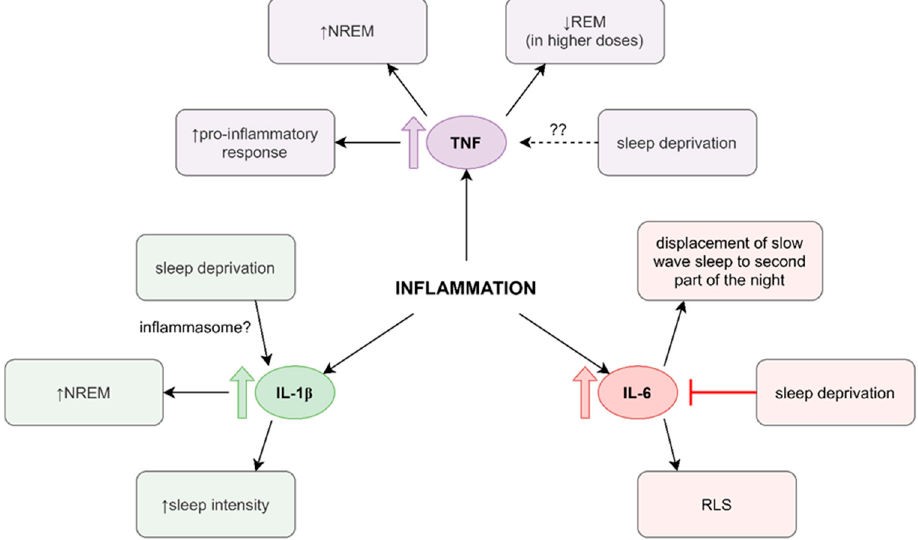
Figure 1. Sleep and inflammation. Notes: Inflammation is associated with relatively high levels of interleukin (IL) 6, IL-1 β , and tumor necrosis factor (TNF). IL-6 might promote slow-wave sleep in the second half of the night while suppressing it in the first half. It might also contribute to restless leg syndrome (RLS) through stimulation of hepcidin production, which can cause iron deficiency. Sleep deprivation (SD) early in the night might cause relatively low IL-6 levels and change its pattern of secretion. IL-1 β might improve non-rapid eye movement sleep (NREM) length and sleep intensity. Its levels increase after SD, suggesting the influence of SD on inflammasome, a potentially interesting subject for future studies. TNF stimulates immune response through suppression of Treg lymphocytes, recruitment of the immune cells, etc. It appears to promote NREM while suppressing REM. Studies’ results on the influence of SD on TNF levels are unequivocal.